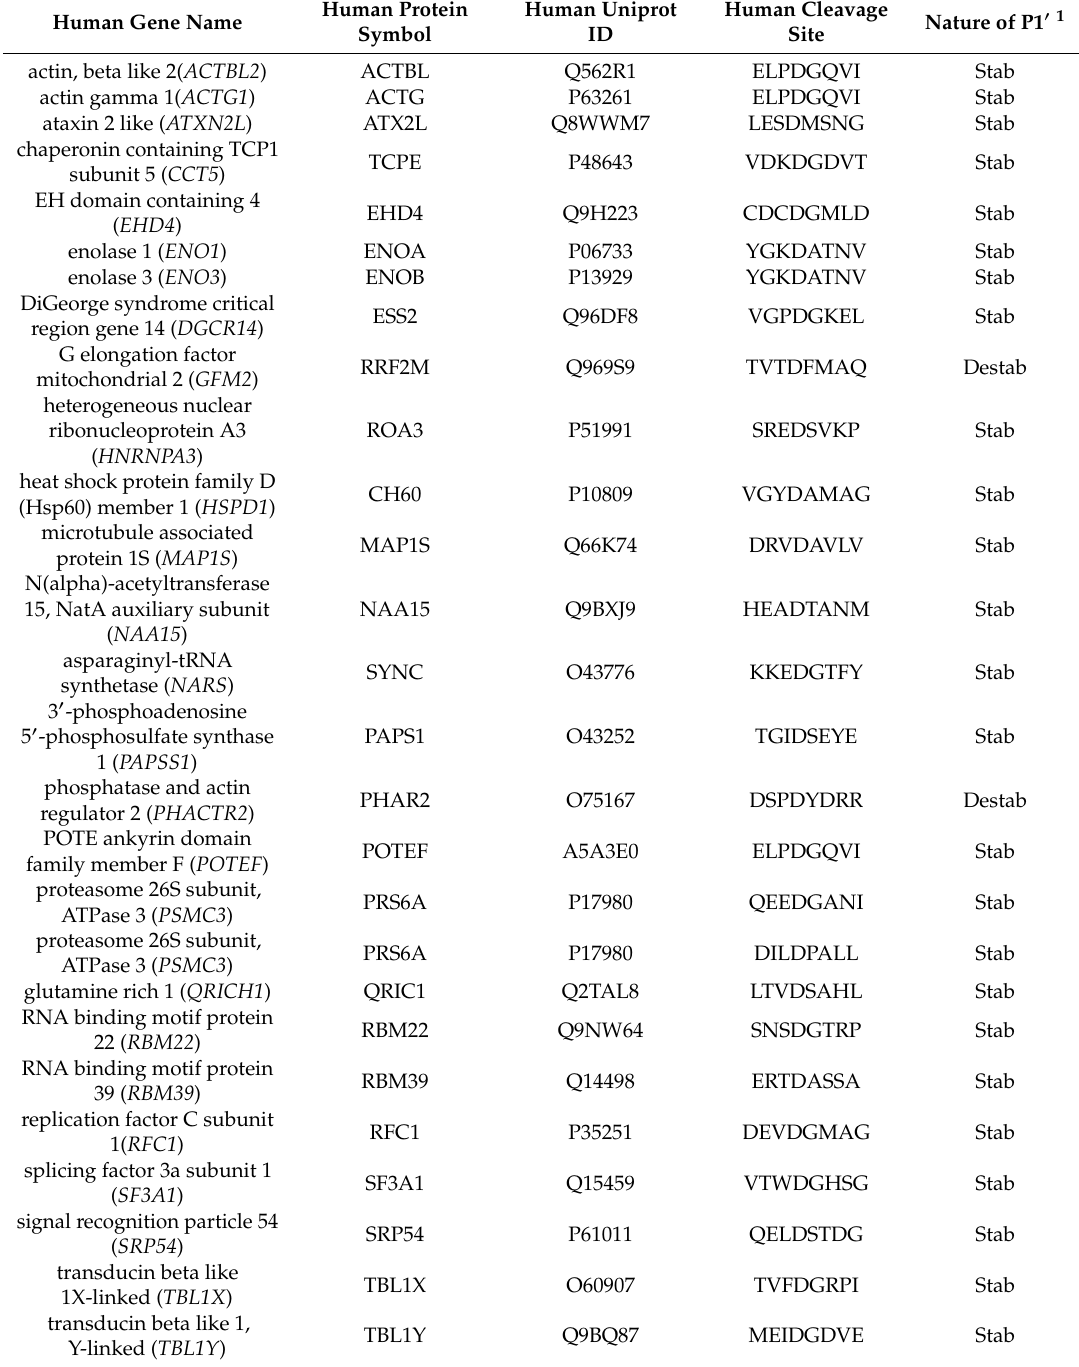
Table 5. Novel apoptotic mediators not previously related to cancer and